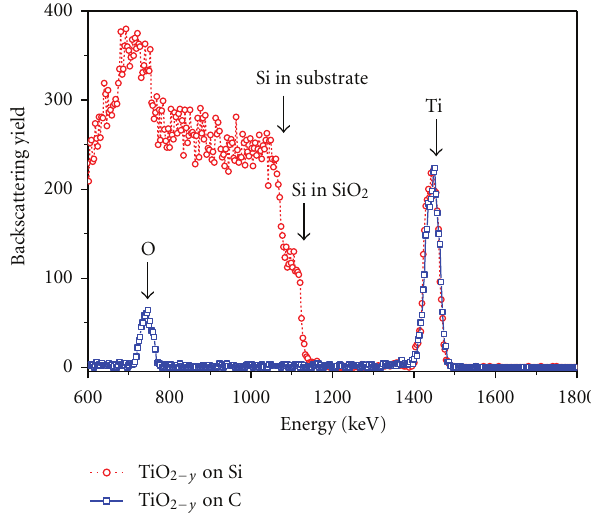
Figure 3: Comparison between the experimental RBS spectra of a TiO 2 − y thin film deposited by rf sputtering on di ff erent substrates: thermally oxidized Si wafer (Si/SiO 2 ) and carbon foil